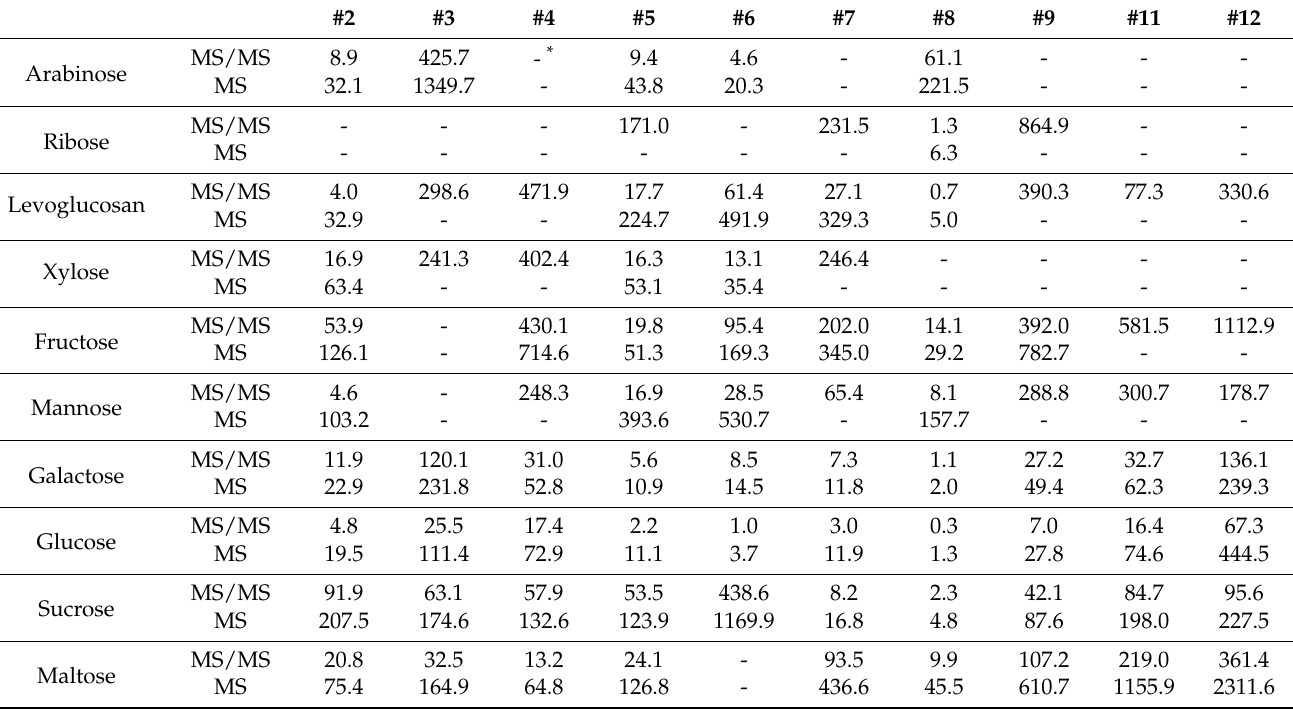
Table 9. Sampling time (min) required to obtain a PM 2.5 sample using a high-volume air sampler at a flow rate of 700 L/min to allow the quantification of saccharides using GC-MS/MS and